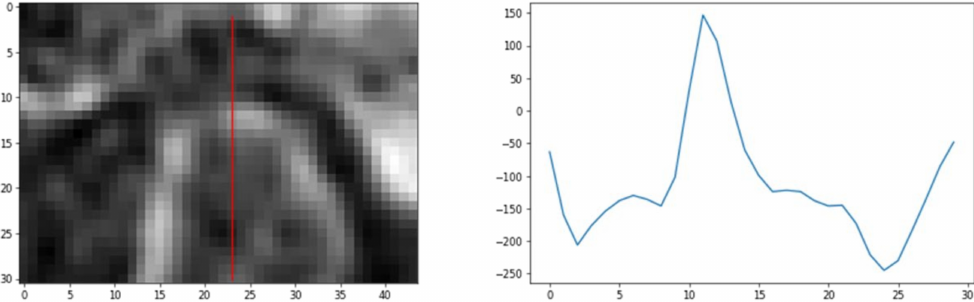
Figure 6. The CBCT image slice with a profile line in red ( left image), and the voxels values across the line ( right